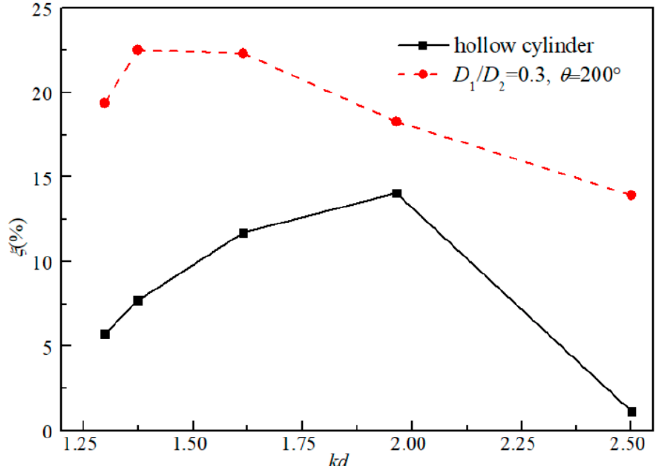
Figure 4. Comparison of the wave energy conversion efficiency ξ between dual-cylinder type OWC and hollow-cylindrical OWC.